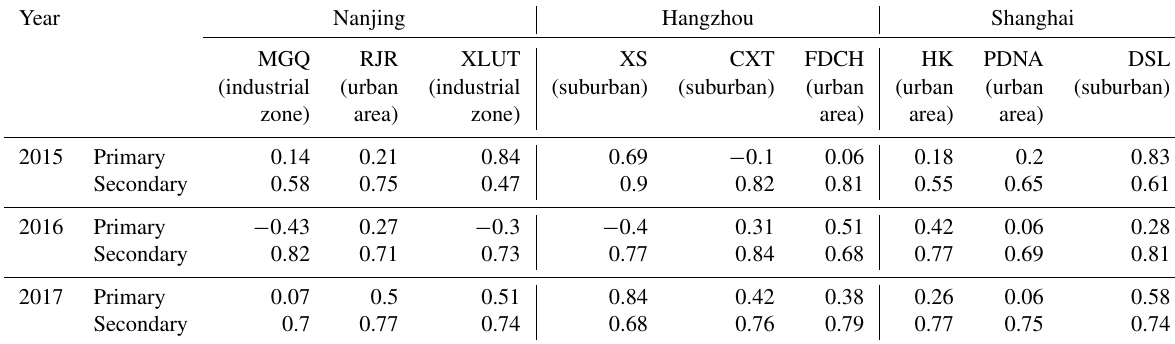
Table 2. The Pearson correlation coefficient ( R ) between the measured HCHO and primary HCHO emissions and secondary HCHO forma- tion in Nanjing, Hangzhou, and Shanghai from 2015 to 2017. Line 1 in each year refers to primary HCHO and line 2 refers to secondary